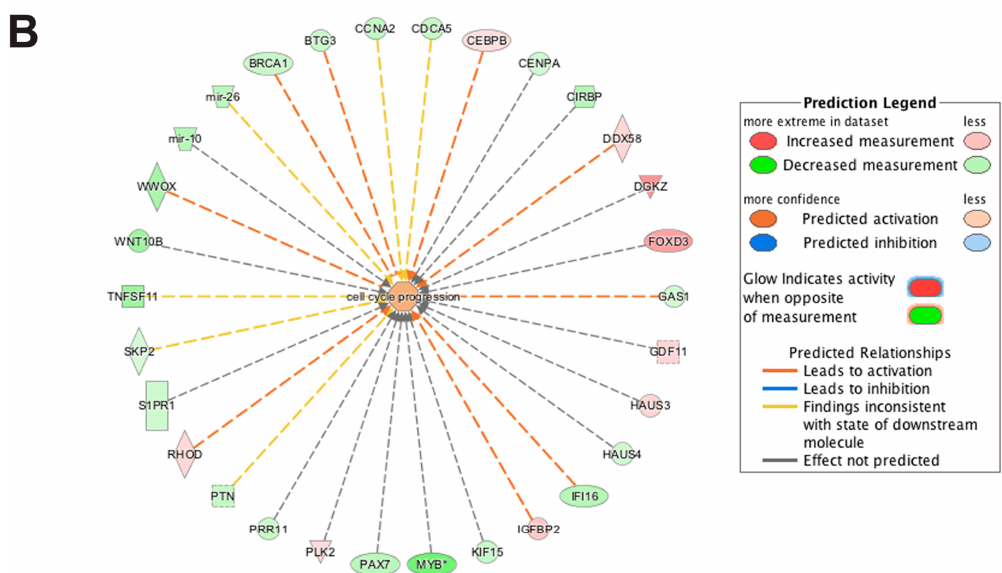
Figure 7. Ingenuity pathway analysis of differentially expressed genes unique to wildtype cells during transition from day 0 to day 1 of differentiation. ( A ) Human Embryonic Stem Cell Pluripotency was identified as a top canonical pathway containing differentially expressed genes unique to wildtype cells. The network was generated through the use of ingenuity pathway analysis (IPA) (Ingenuity Systems, www.ingenuity.com) on normalized mRNA values. Nodes represent molecules in a pathway, while the biological relationship between nodes is represented by a line (edge). Edges are supported by at least one reference in the Ingenuity Knowledge Base. The intensity of color in a node indicates the degree of up- (red) or down- (green) regulation. Nodes are displayed using shapes that represent the functional class of a gene product (Circle = Other, Nested Circle = Group or Complex, Rhombus = Peptidase, Square = Cytokine, Triangle = Kinase, Vertical ellipse = Transmembrane receptor). Edges are marked with symbols to represent the relationship between nodes (Line only = Binding only, Flat line = inhibits, Solid arrow = Acts on, Solid arrow with flat line = inhibits and acts on, Open circle = leads to, Open arrow = translocates to). ( B ) Biological Functional Analysis using IPA predicts activation of cell cycle progression from differentially expressed genes unique to wildtype cells during transition from day 0 to day 1 of differentiation ( p -value: <0.05). The figure represents genes that are associated with a particular biological function that are altered in the uploaded dataset. Genes that are up-regulated are displayed within red nodes and those down-regulated are displayed within green nodes. The intensity of the color in a node indicates the degree of up-(red) or down-(green) regulation. The shapes of the nodes reflect the functional class of each gene product: transcriptional regulator (horizontal ellipse), transmembrane receptor (vertical ellipse), enzyme (vertical rhombus), cytokine/growth factor (square), kinase (inverted triangle) and complex/group/other (circle). An orange line indicates predicted upregulation, whereas a blue line indicates predicted downregulation. A yellow line indicates expression being contradictory to the prediction. Gray line indicates that direction of change is not predicted. Solid or broken edges indicate direct or indirect relationship, respectively.